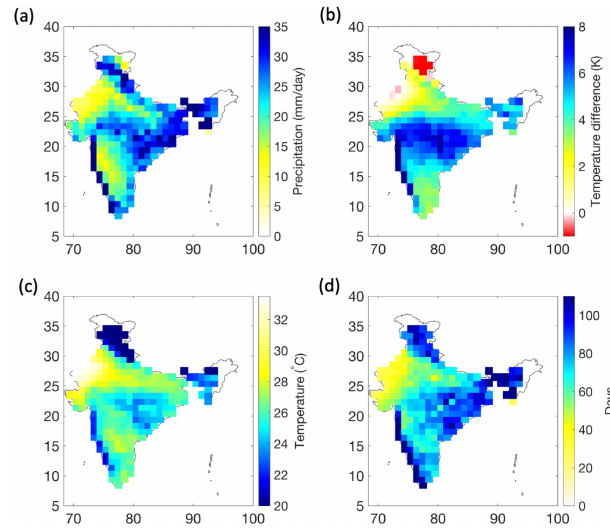
Figure 4. Regional variation of (a) mean daily extreme precipitation (99th percentile), (b) the temperature difference between clear-sky and all-sky radiative conditions averaged during extreme precipita- tion events, (c) all-sky surface temperature during the occurrence of the event and (d) mean number of rainfall days per